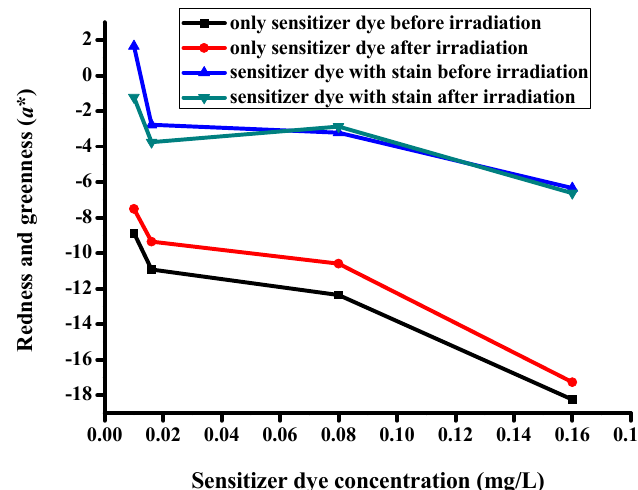
Figure 10. The a * values of the dye/TiO 2 ‐ coated cotton fabrics.